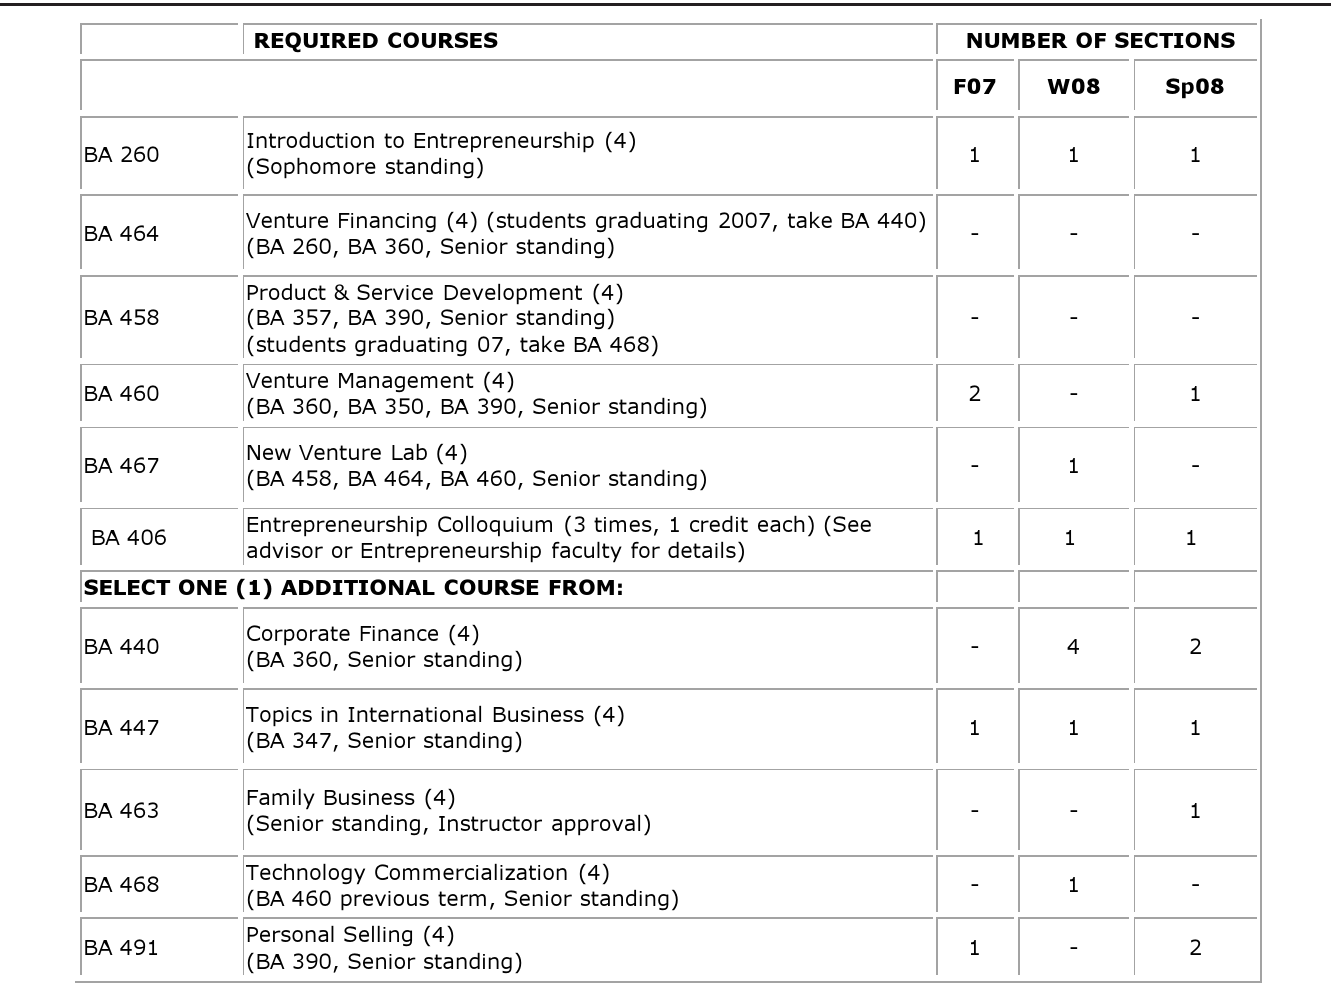
Figure 3. Proposed Entrepreneurship